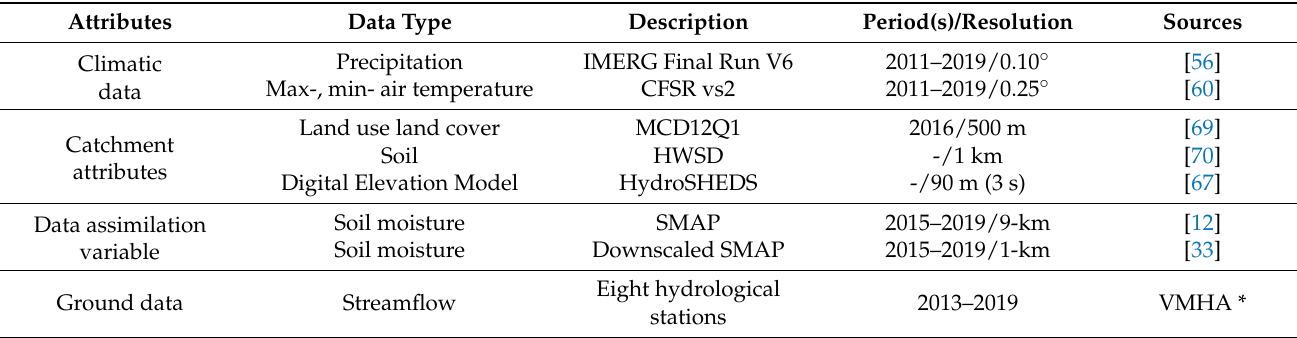
Table 3. Description of data used for SWAT and data assimilation framework in this